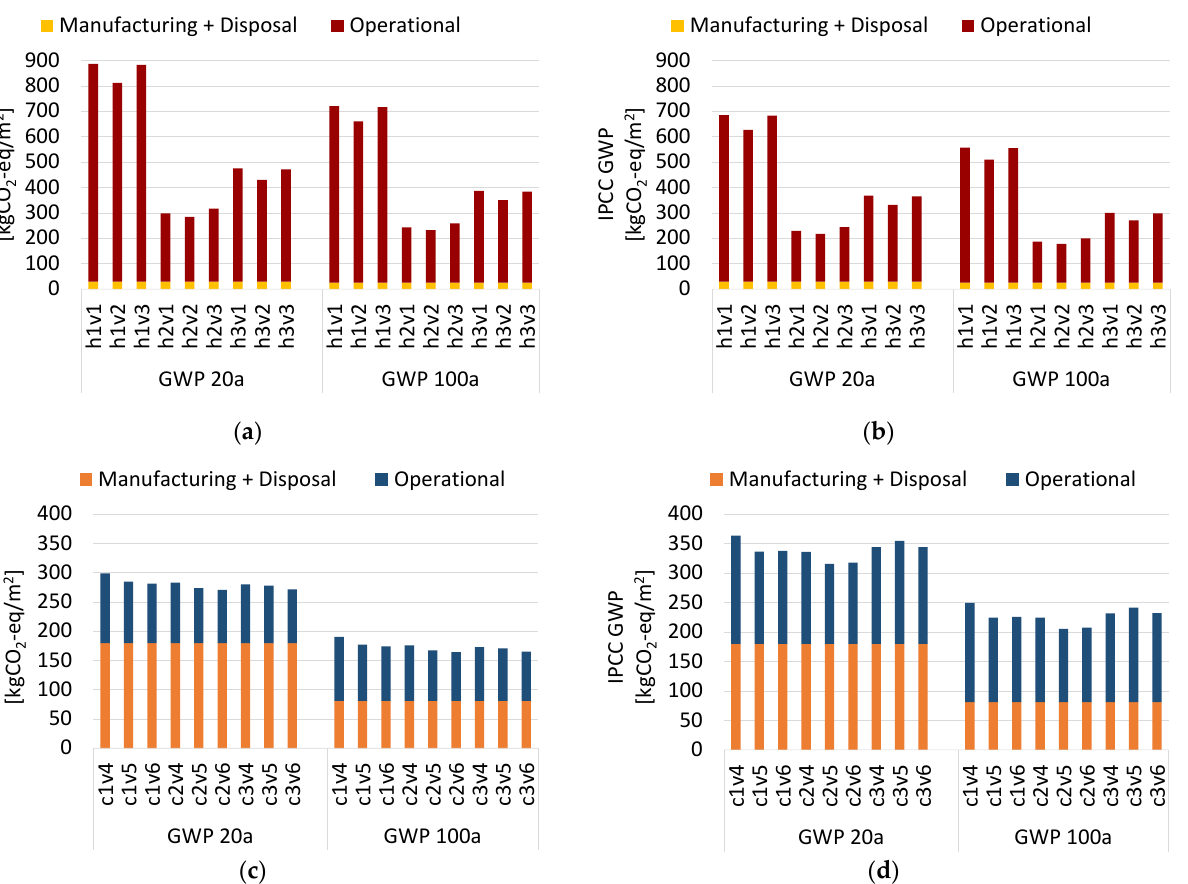
Figure 6. Comparison of the total results per m 2 of floor area (manufacturing and disposal + operational stage) using the indicator IPCC GWP 20a and GWP 100a calculated: For heating with ( a ) LCA b ; and ( b ) LCA cc ; and for cooling with ( c ) LCA b ; and ( d ) LCA cc .